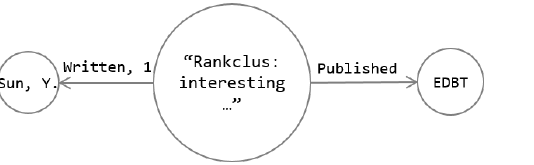
Figure 3. Example of bibliographic information network (BIN)